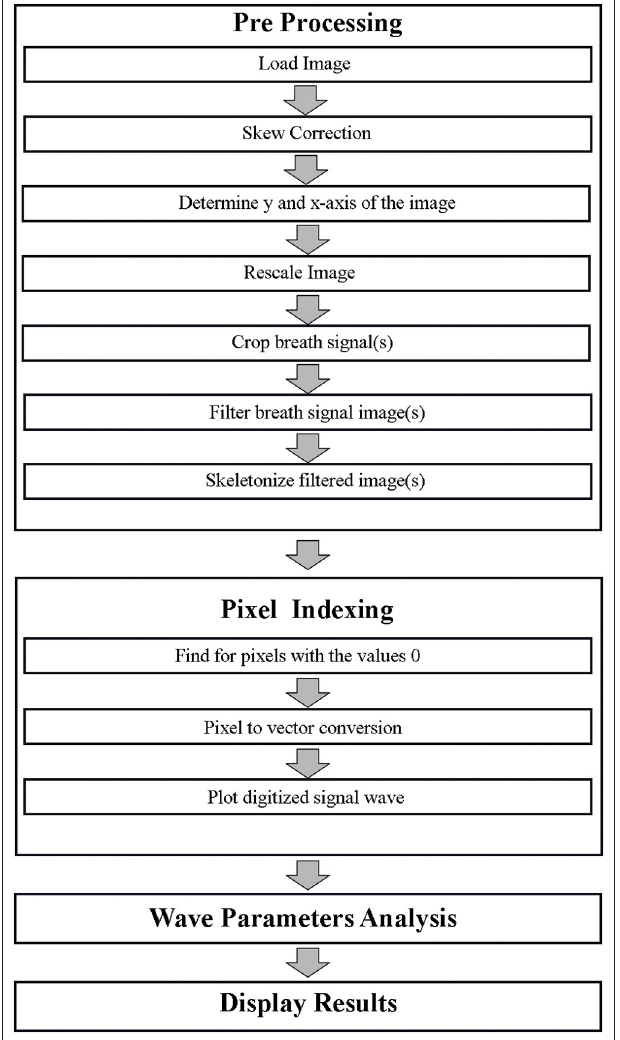
FIGURE 1 | Capnographic image digitization